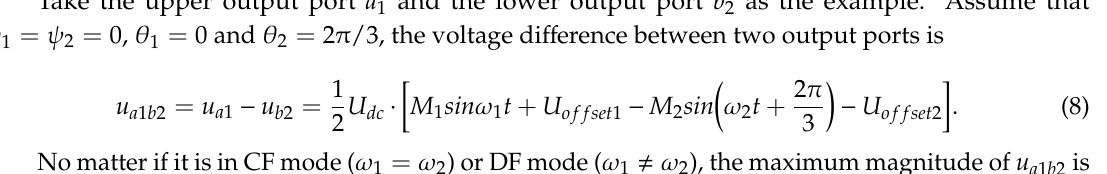
Figure 8. Potential flow path of short-circuit current ( a 1 – dc side – b 2